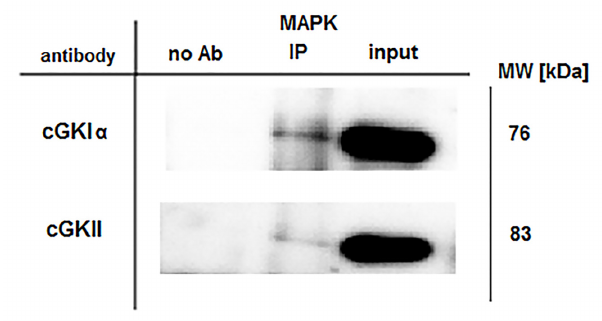
Fig 6. Detection of the protein-protein interaction between cGK and MAPK by co- immunoprecipitation. Jejunum WT tissue lysate was incubated with protein A Sepharose beads coupled with the p44/42 MAPK antibody. After immunoprecipitation, the protein complexes were visualized by Western blotting using antibodies directed against cGKI α and cGKII. For the immunoprecipitation (IP), no antibody (no Ab) was used as a negative control and untreated tissue lysate (1 μ g/ μ L, indicated with input) was used as an additional